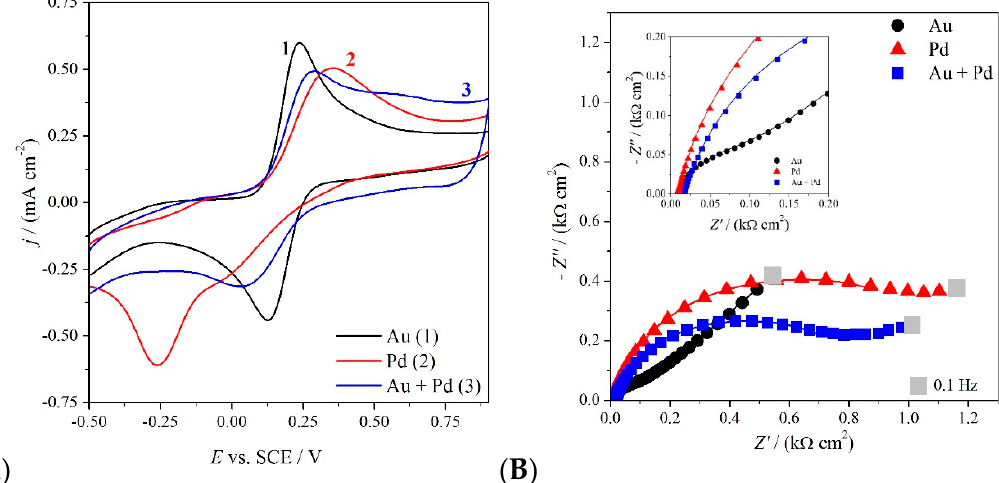
Figure 4. Cyclic voltammetry at 0.1 V·s − 1 ( A ) and impedance Nyquist plots taken at 0.25 V ( B ) of GC electrode modified with AuNP (1), PdNP (2) and Au-Pd alloy (3), in the presence of 3 mM K 4 [Fe(CN) 6 ] in 0.1 M KCl.